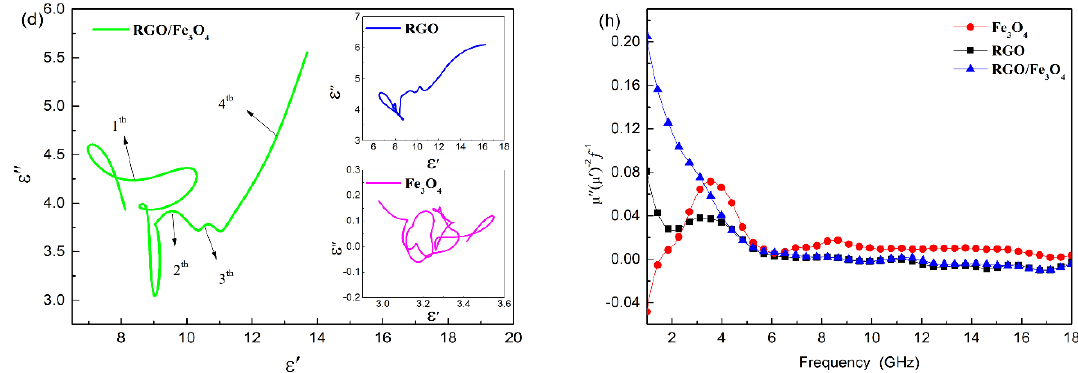
Figure 4. Electromagnetic characteristics of Fe 3 O 4 nanoparticles (NPs), RGO and RGO / Fe 3 O 4 nanocomposites: ( a ) real (ε’) and ( b ) imaginary (ε’’) parts of complex permittivity; ( c ) dielectric loss tangent ( tanδ ε ); ( d ) Cole–Cole semicircles ( ε ’’ vs. ε ’); ( e ) real ( μ ’) and ( f ) imaginary ( μ ’’) parts of complex permeability; ( g ) magnetic loss tangent ( tanδ μ ); and ( h ) μ ’’( μ ’) −2 f −1 vs. f .